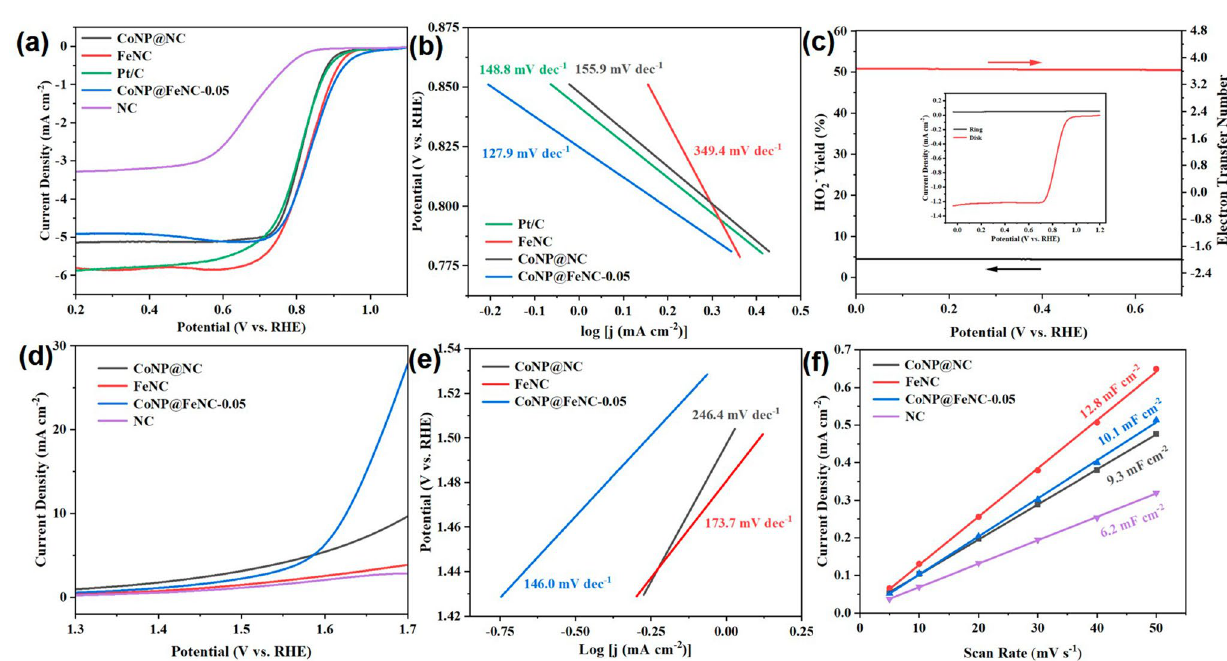
Fig. 4 a LSV curves of catalysts for ORR with a scan rate of 5 mV s −1 under 0.1 M KOH, at 1600 rpm. b Tafel plots of catalysts for ORR. c Electron transfer number and HO 2− yield of CoNP@FeNC-0.05 derived from the RRDE tests under 0.1 M KOH. d LSV curves of catalysts for OER with a scan rate of 5 mV s. −1 under 1 M KOH, at 1600 rpm. e Tafel plots of catalysts for OER. f Plots of current density versus scan rate under 0.1 M KOH. The slopes of the curves correspond to the C dl values of